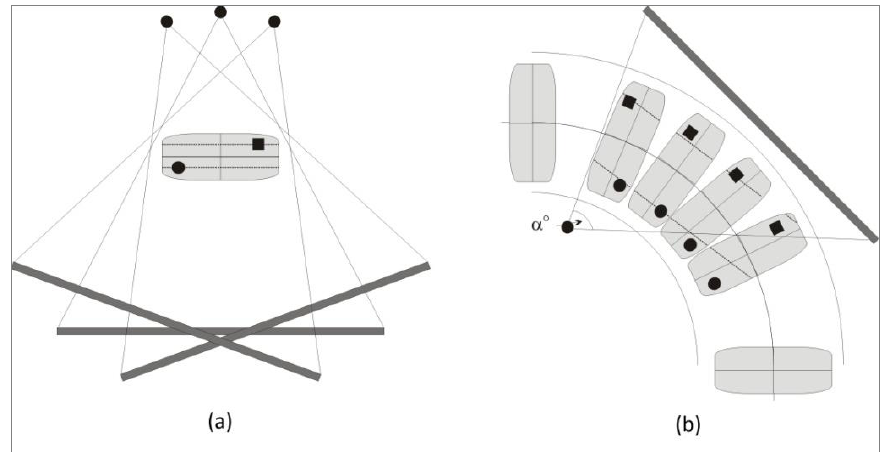
Figure 1 . Schematic of (a) ‘normal’ tomosynthesis and (b) ‘on-belt’ tomosynthesis systems. (a) shows an arrangement of moving sources and detectors around a static object and (b) shows and arrangement of static sources and detectors around a conveyor bend. The movement of objects around the conveyor bend enables multiple views of different orientations of the objects to be made. Figure adapted from Reid et al. (2011)